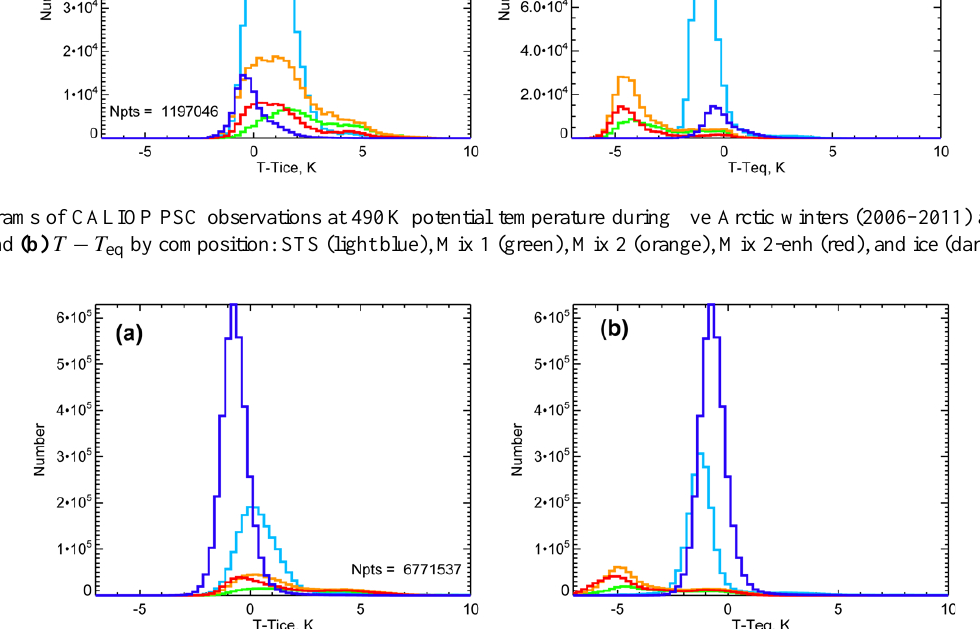
Fig. 9. Histograms of CALIOP PSC observations at 490K potential temperature from six Antarctic winters (2006–2011) as a function of (a) T − T ice and (b) T − T eq by composition: STS (light blue), Mix 1 (green), Mix 2 (orange), Mix 2-enh (red), and ice (dark